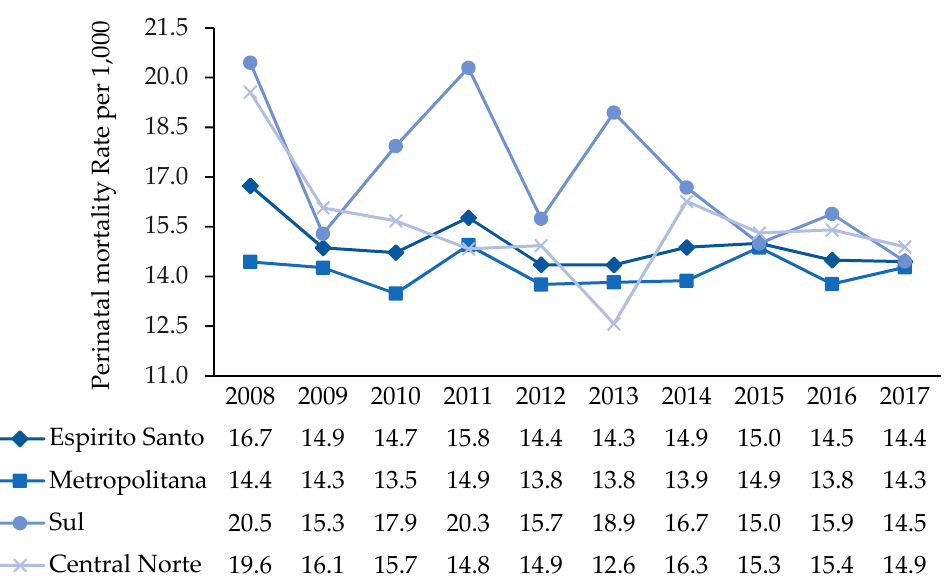
Figure 2. Perinatal mortality rate by health region. Espírito Santo, Brazil, 2008–2017 . Source: MS/SVS/CGIAE—Sistema de Informações sobre Mortalidade (SIM) e MS/SVS/DASIS—Sistema de Informações sobre Nascidos Vivos (SINASC), 2021.